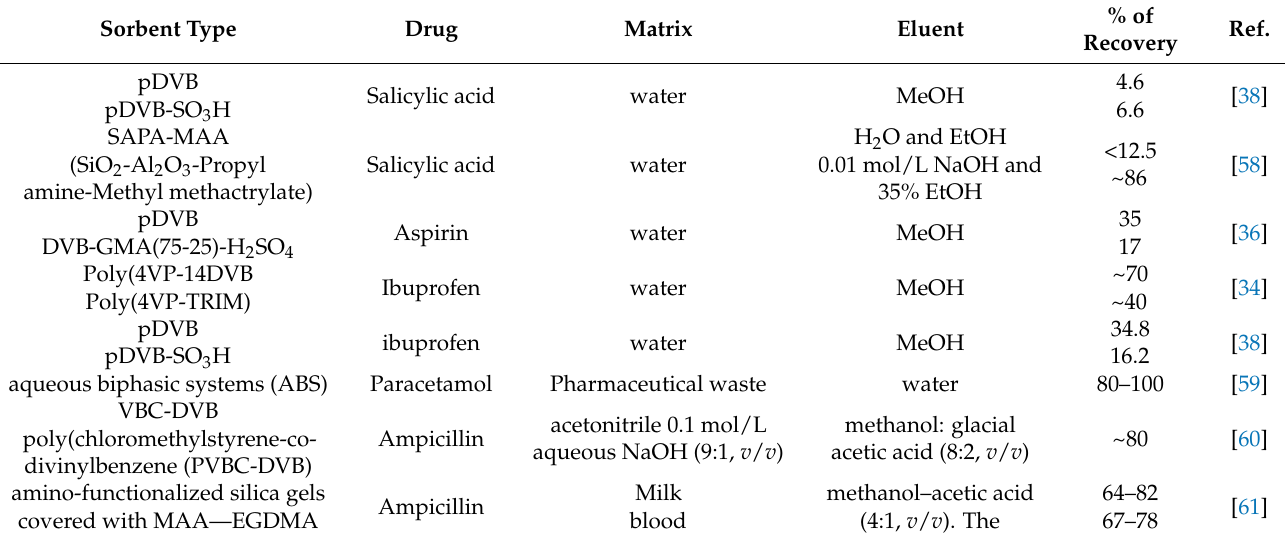
Table 7. Comparison table of drug recoveries reported in the